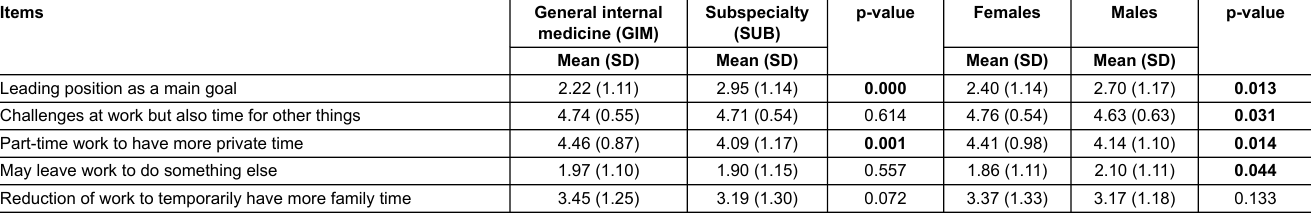
Table 4: Perceptions of the future in the next 5 years, by medical specialty (n = 340) and by gender (n = 392). Scale from 1 “not at all” to 5 “completely”. The table shows mean scores, standard deviations (SD) and p-values.